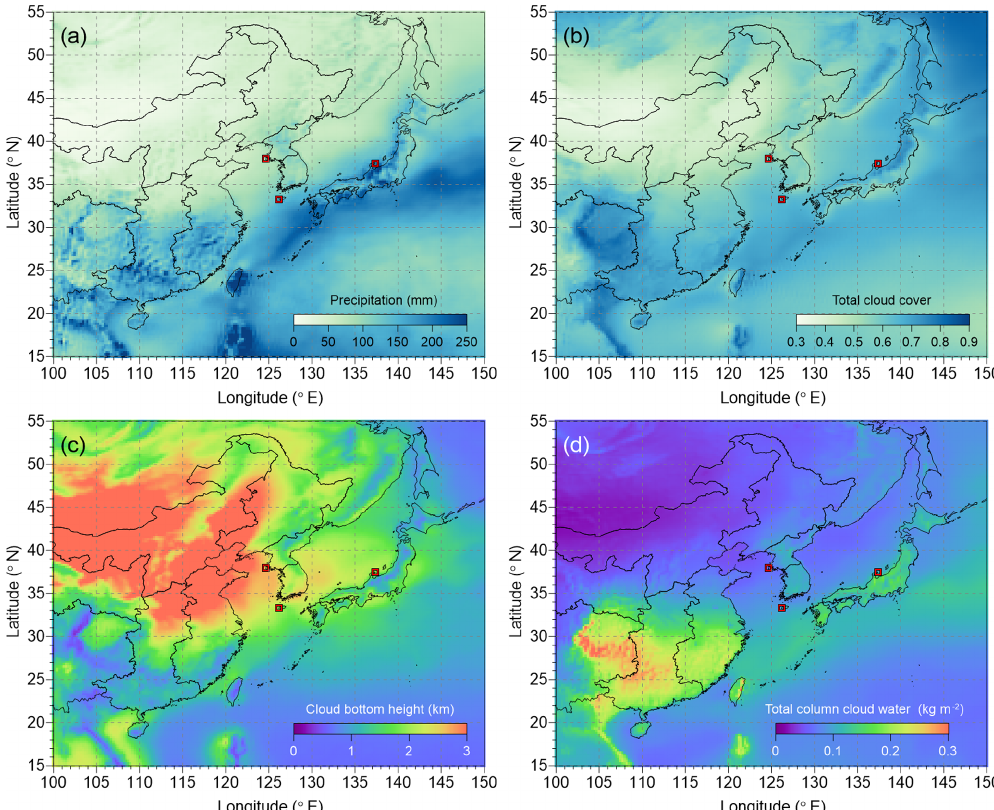
Figure 3. Monthly mean meteorological fields over East Asia from 2010 to 2016 derived from the European Centre for Medium-Range Weather Forecasts (ECMWF) ERA5 monthly averaged data at single levels. (a) Precipitation (millimeters), (b) total cloud cover, (c) cloud bottom height (kilometers), and (d) total column cloud total water (ice and